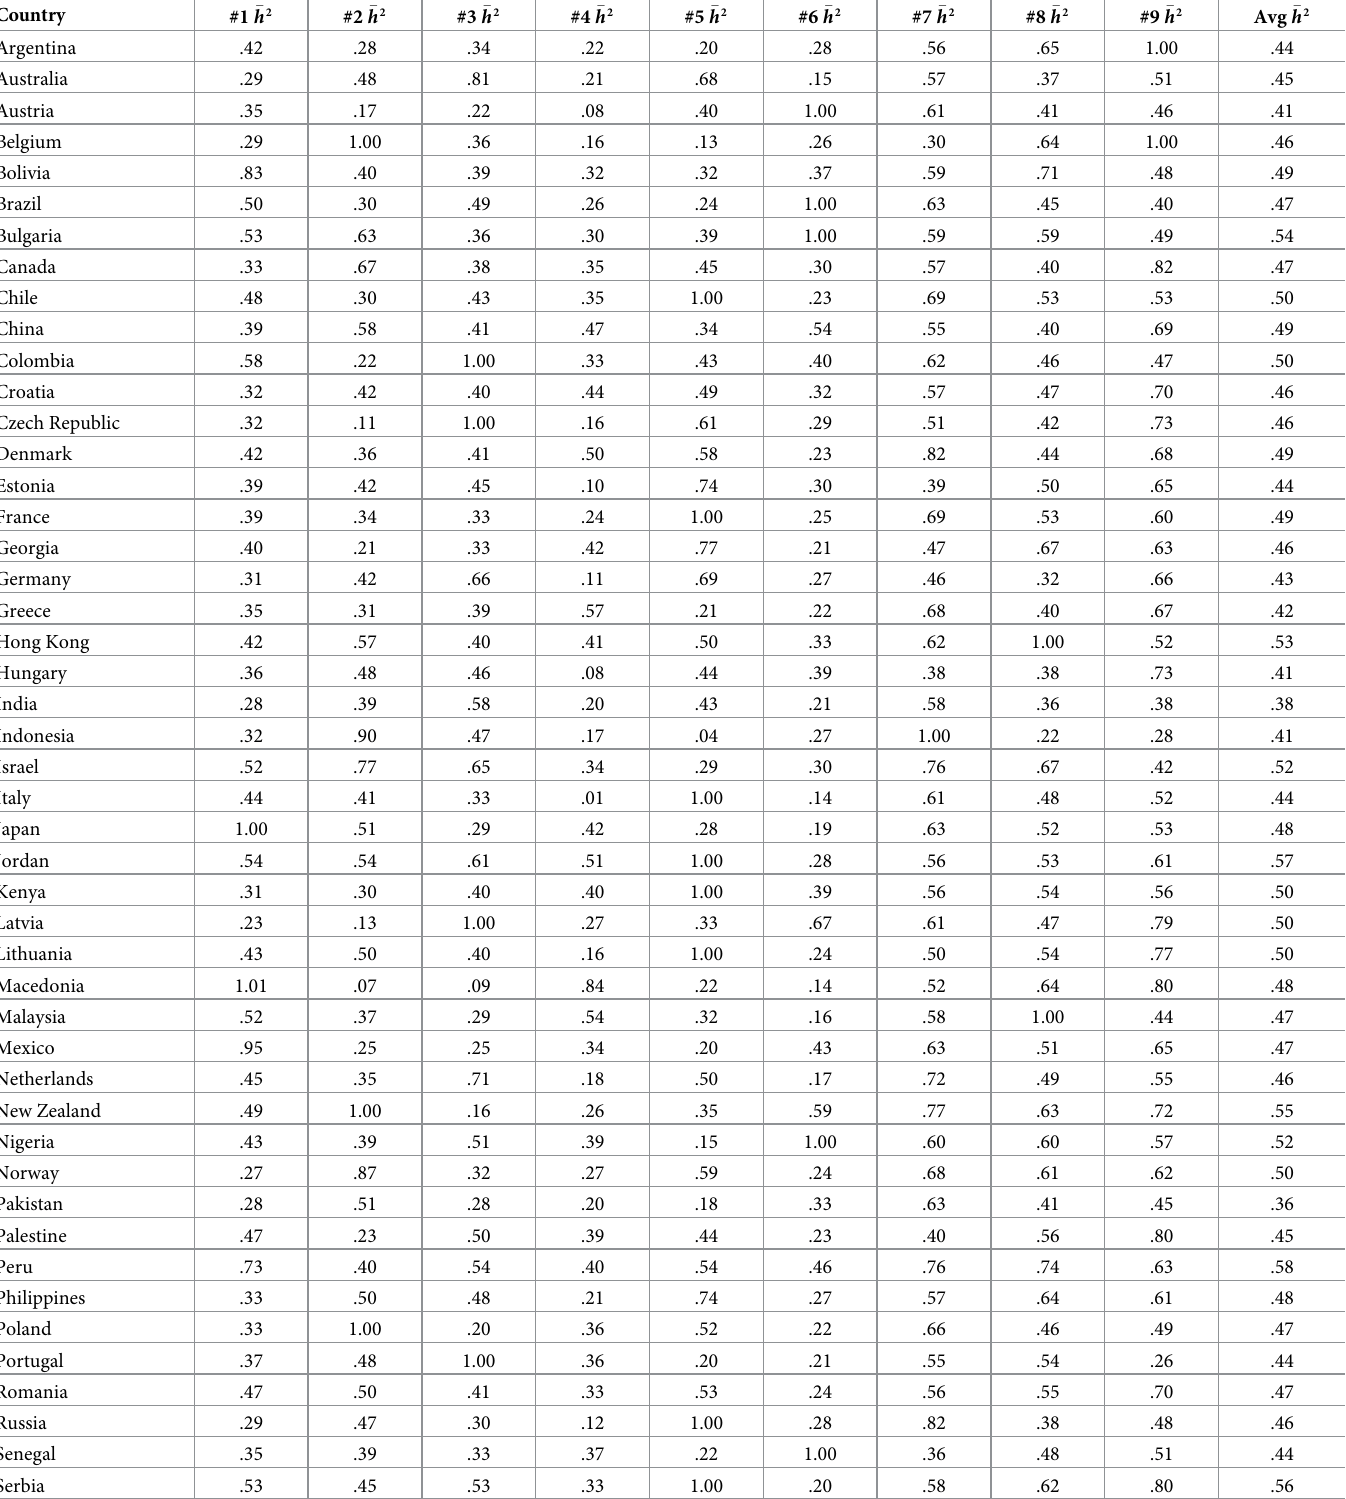
Table 6. Communality scores ( � h 2 ) for the Subjective Happiness Scale (SHS).